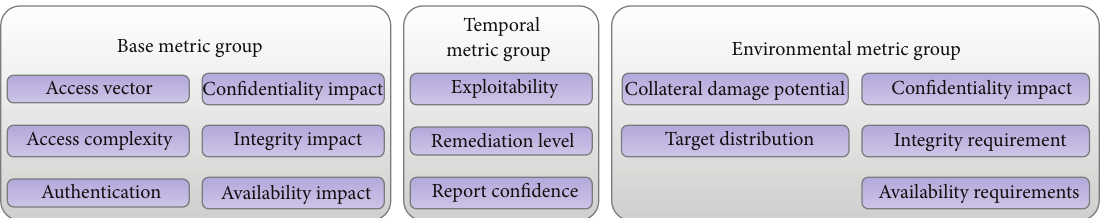
Figure 1: CVSS metric